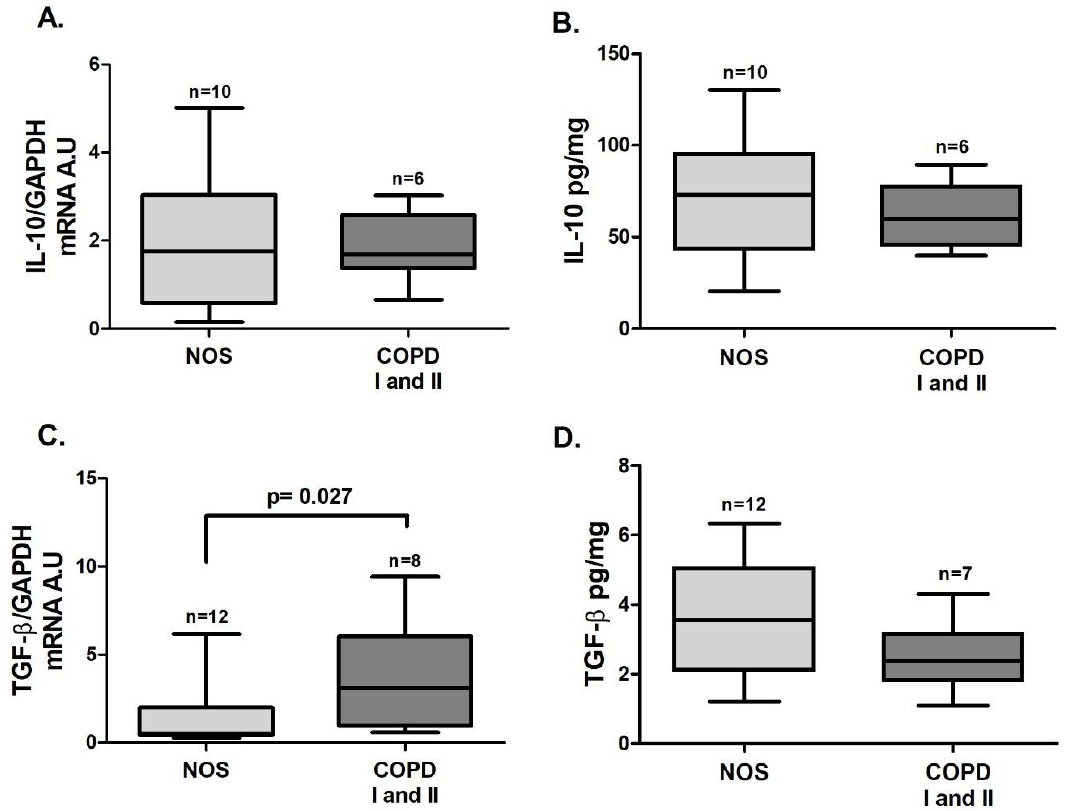
Figure 6. Treg-related cytokines in lung tissue samples. Treg-related cytokine expression in lung tissue samples: no differences were observed for IL-10 gene expression ( A , Mann–Whitney test) or IL-10 and TGF- β levels ( B , Mann–Whitney test; D , t -test) between groups; ( C ) increased TGF- β gene expression ( p = 0.027, Mann–Whitney test) in the COPD I and II group. The data are expressed as the as the median and interquartile range. A.U: Arbitrary Units.